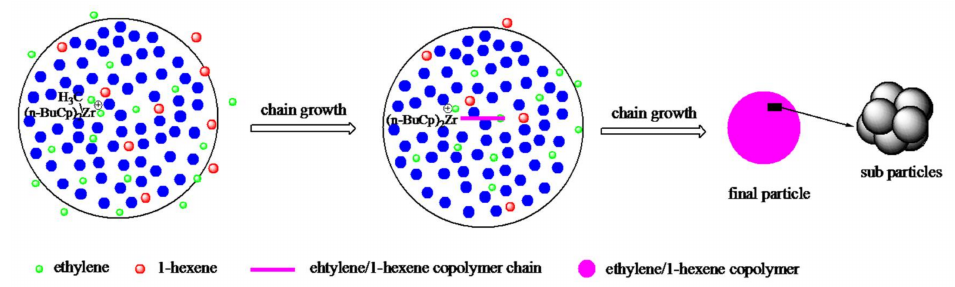
Figure 3. Schematic incorporation mechanism of comonomers by diffusion through different pore sizes of the POPs-supported metallocene catalysts during ethylene/1-hexene